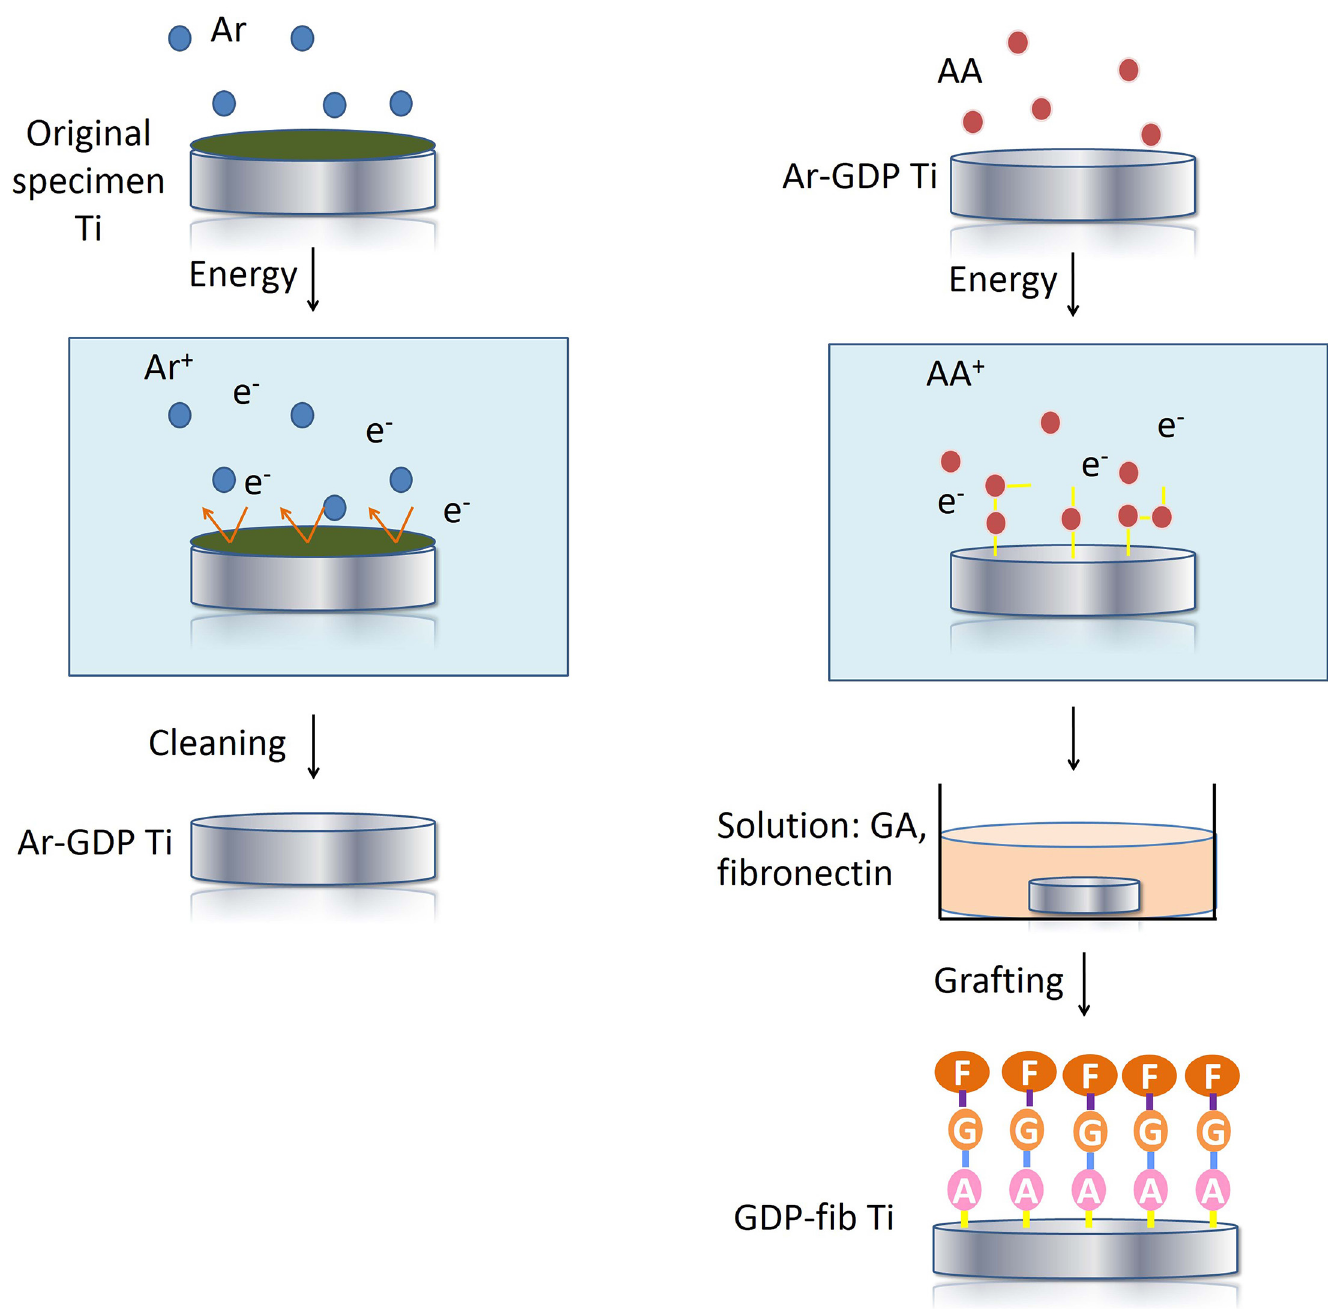
Fig 2. Schematic of sample preparation. (a)The surfaces of Ti discs (original specimens) were cleaned with argon-based GDP. These titanium discs were then labeled as “ Ar-GDP. ” (b) Amine groups were grafted onto the Ar-GDP surfaces in the GDP reactor fed with allylamine (AA) gas. These specimens were subsequently treated in glutaraldehyde (GA) and fibronectin solutions and were labeled as “ GDP-fib ”